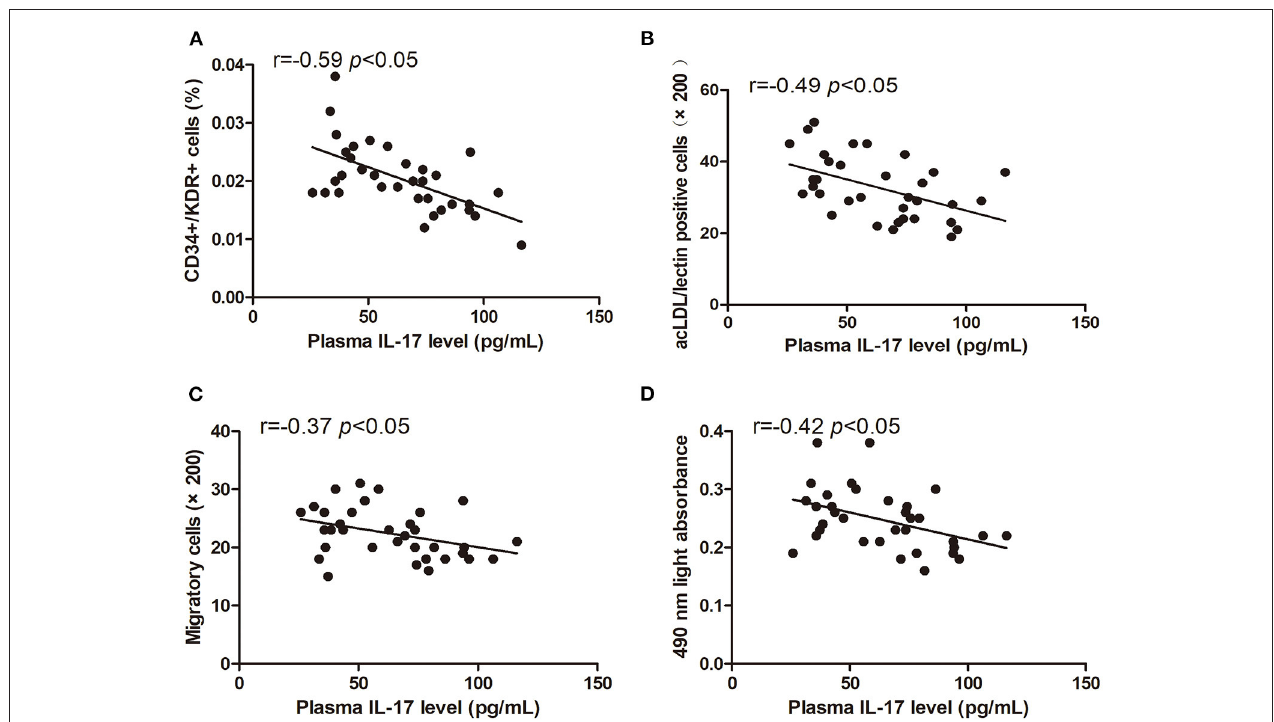
FIGURE 6 | Pearson correlation ratios were used to analyze the relationship between the number or function of EPCs and plasma IL-17 level. The CD34 + KDR + positive cells (A) and DiI-acLDL/lectin positive cells (B) significantly correlated with IL-17. The migratory (C) and proliferative (D) activities of EPCs were related to